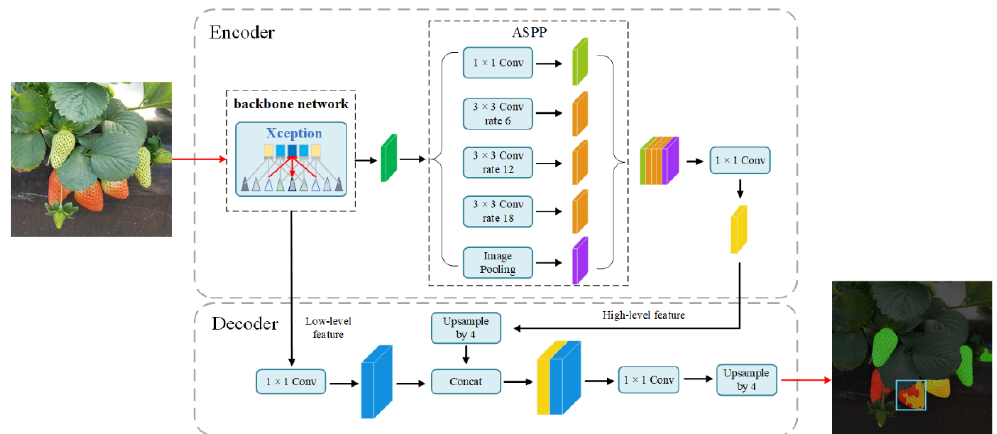
Figure 5. DeepLabV3+ structure and segmentation effect.